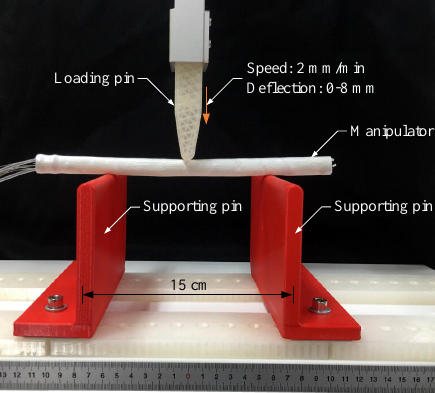
Figure 7. Experiment setup for bending stiffness test using the fabricated prototype of the